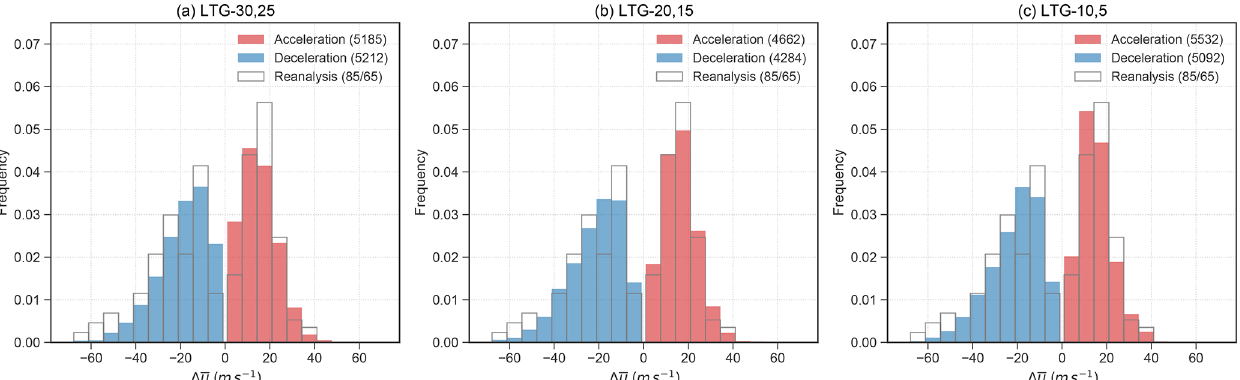
Figure 2. Distributions of the wind change ((cid:49)u) of the acceleration and deceleration events identified from reanalysis (transparent bars with grey outline) and the acceleration (red) and deceleration (blue) events identified from the ensemble members in the hindcasts that are initialised in NH winter at (a) LTG-30,25, (b) LTG-20,15 and (c) LTG-10,5. Numbers in parentheses indicate the number of identified events at each lead time. The reanalysis distributions displayed in all panels are identical, and the numbers in brackets refer to the number of acceleration/deceleration events. The histograms are